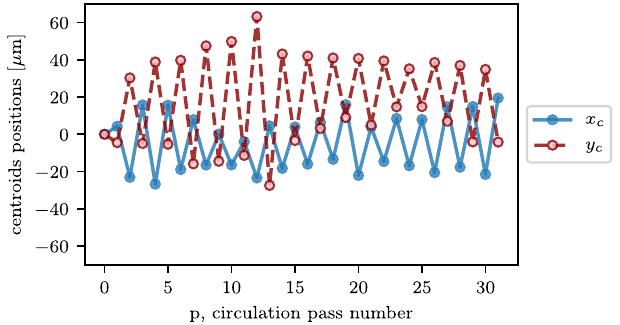
FIG. 27. Experimental circulation traces obtained by averaging 10 circulation traces after the retuning of the MPS30 and